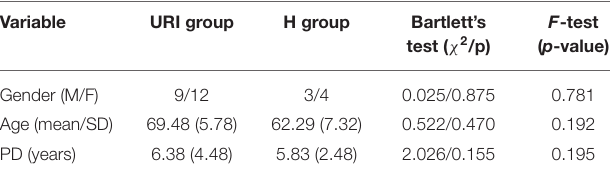
TABLE 1 | Analyzing differences between the home (H) group and hospital (URI)